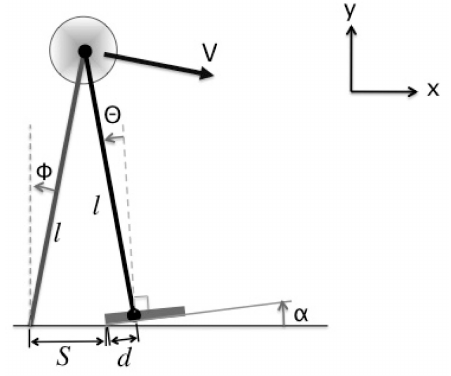
Figure 15. Modeling of bipedal robot during the Heel Impact